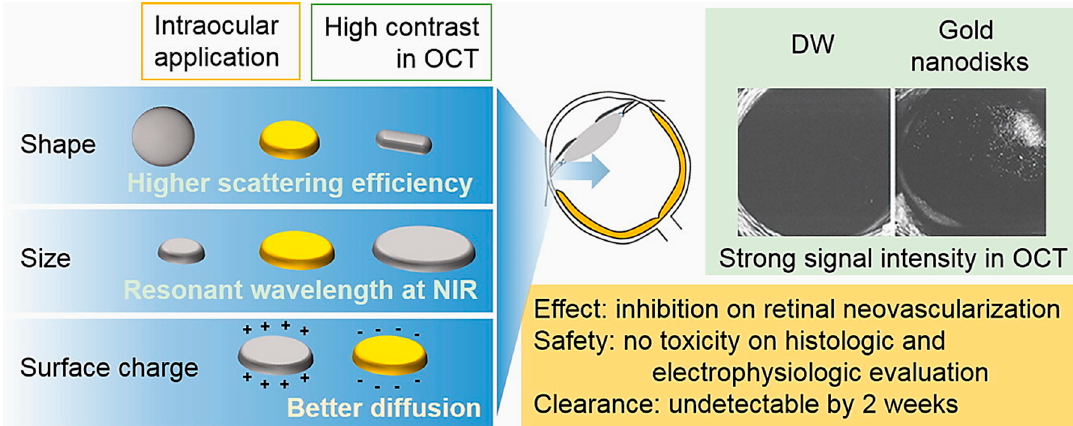
Figure 3. Schematic representation of gold nanodisks (GNDs) effects in retinal degeneration and Optical Coherence Tomography (OCT) imaging. The GNDs were particularly suitable for their optical properties connected to the shape: GNDs absorbed in the Near Infrared Region (NIR). The size and surface charge also influenced the eye diffusion. In OCT images, GNDs exhibited a strong signal compared to the dual window (DW) processing method, which is used to detect modulation of OCT signals due to scattering or absorption. Reprinted from [80] Copyright (2017), with permission from Elsevier.